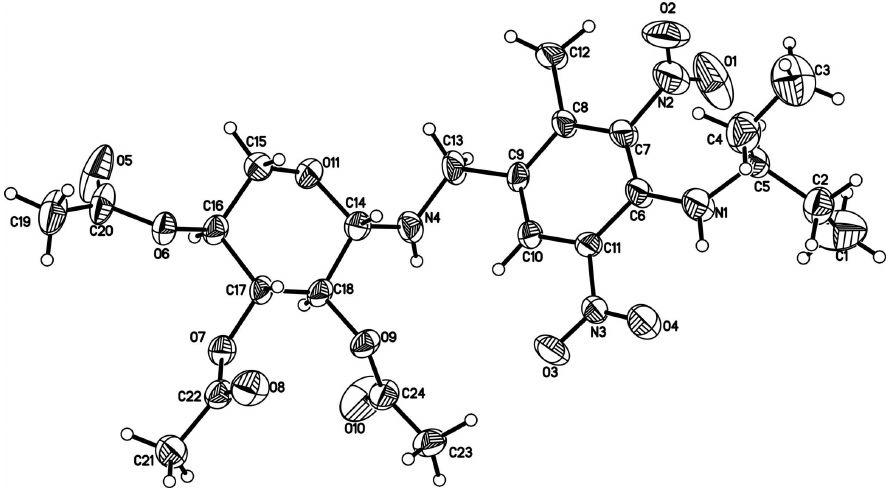
Figure 1 The asymmetric unit of the title compound, showing the atom-labelling scheme. Displacement ellipsoids are drawn at the 50% probability